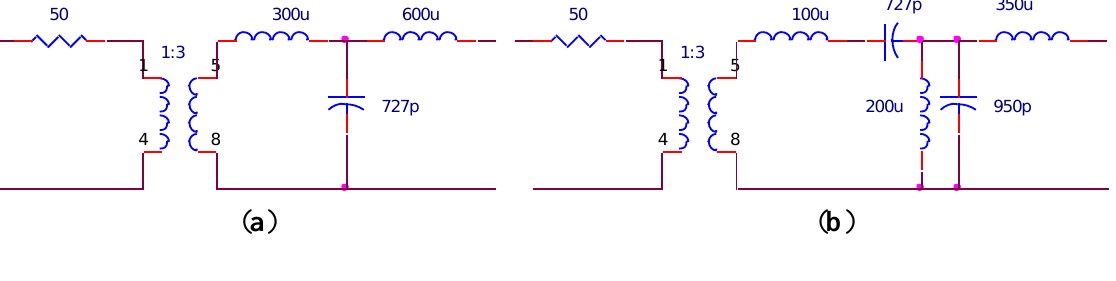
Figure 18. TPG of the EIMNs in Figure